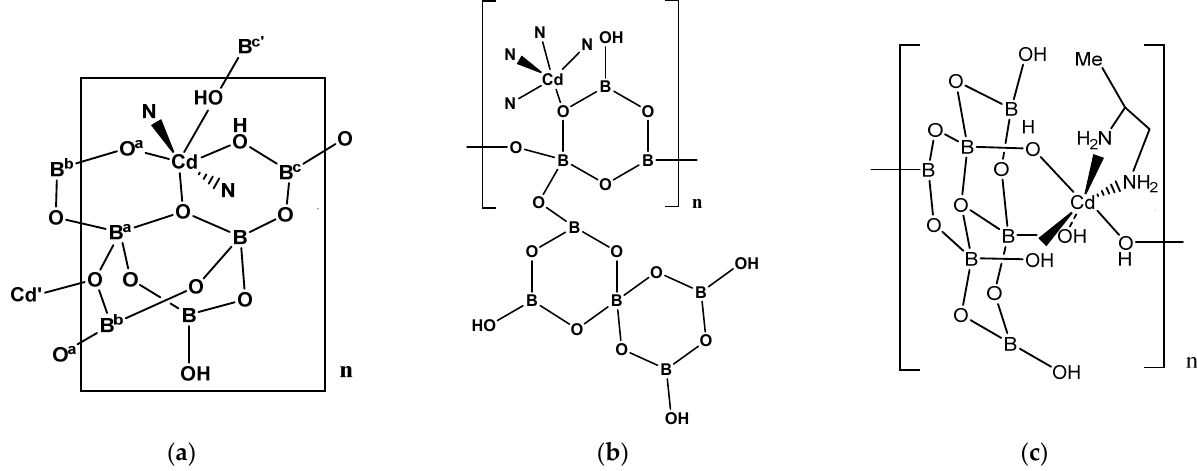
Figure 1. The building units of ( a ) [Cd(dab) 0.5 (dab’) 0.5 {B 5 O 7 (OH) 3 }] n ( 1 ), ( b ) [Cd(tren){B 8 O 11 (OH) 4 }] n ( 3 ), and ( c ) [Cd(pn){B 6 O 7 (OH) 6 }] n. nH 2 O ( 4 ).